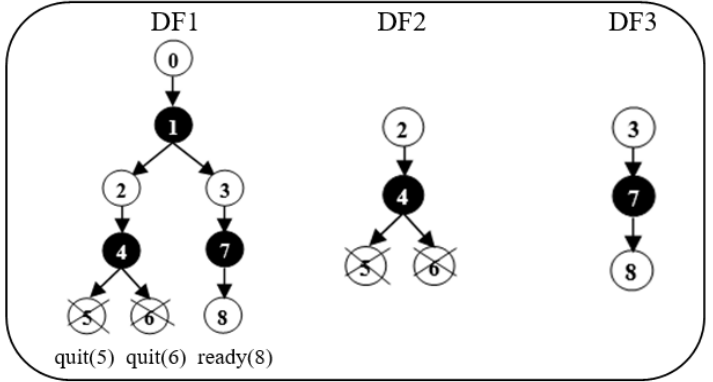
Figure 9. Quit and ready